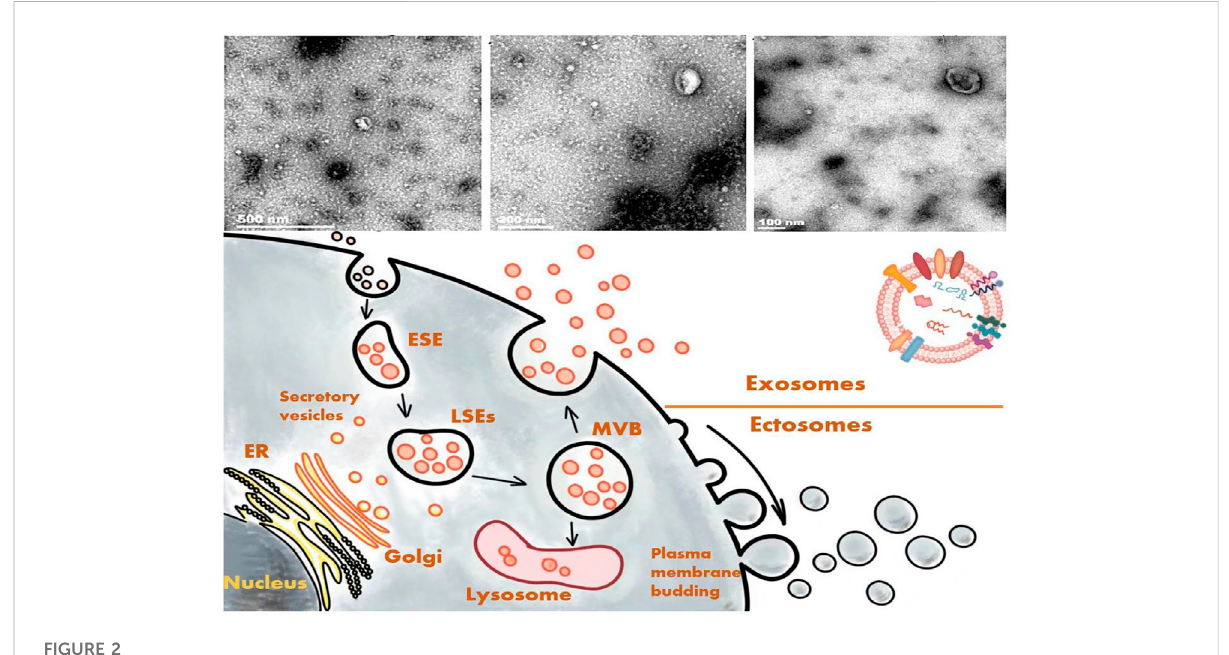
FIGURE 2 Formation process and electron microscope images of